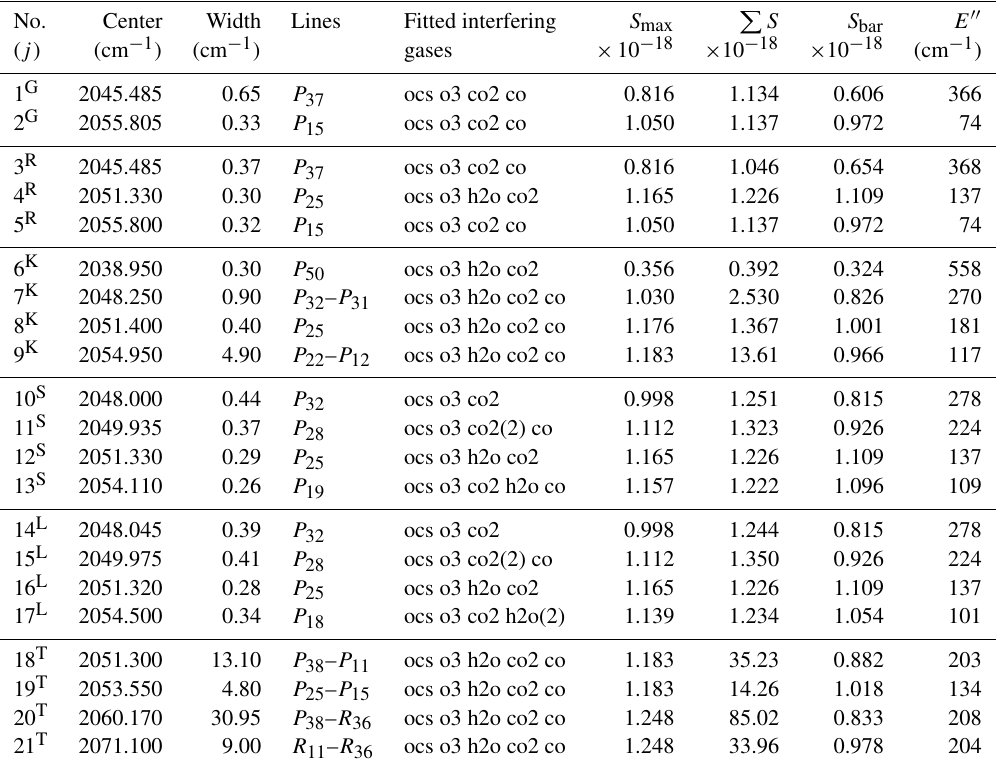
Table B1. Attributes of the 21 ground-based OCS spectral windows evaluated on MkIV ground-based spectra. Center and Width are in units of cm − 1 . Windows 1–17 represent old, previously used windows and are grouped chronologically by reported use. Windows 1–2 were defined by Griffith et al. (1998); 3–5 by Rinsland et al. (2002); 6–9 by Krysztofiak et al. (2015); 10–13 by Kremser et al. (2015); and 14–17 by Lejeune et al. (2017). Windows 18–21 are the new ones. The fitted OCS lines are all from the ν 3 band. The column labeled Lines shows the spectroscopic assignment of the strongest OCS lines in each window (exceeding 1% absorption depth). The number of such lines is simply the difference of the quantum numbers plus 1. So window no. 20 contains 38 + 36 + 1 = 75 lines. Window no. 21 contains 36 − 11 + 1 = 26 lines. S max is the maximum OCS line intensity in units of cm − 1 (moleccm − 2 ) − 1 , P S is the sum of intensities, and S bar is the mean ( S -weighted) intensity. E (cid:48)(cid:48) is the mean ( S -weighted) ground state energy. co2(2) refers to 13 CO 2 ; h2o(2) refers to HDO. The attributes tabulated below are all independent of the measured